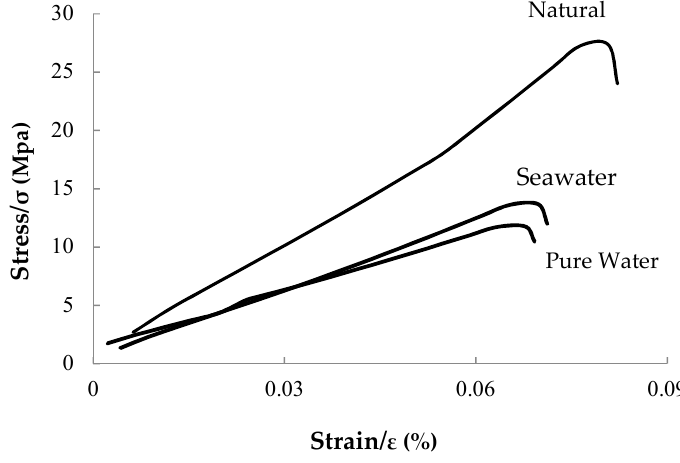
Figure 4. Stress-strain diagram of the three states.